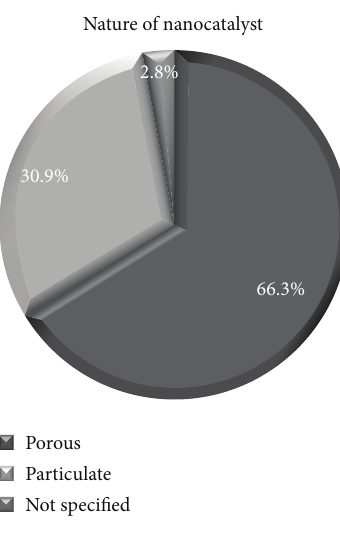
Figure 9: Nature of nanocatalysts described in the selected patents (based on a research on the US Patent and Trademark Office Patent Database (http://patft.uspto.gov/) applying the working definition stated in the beginning of this review).